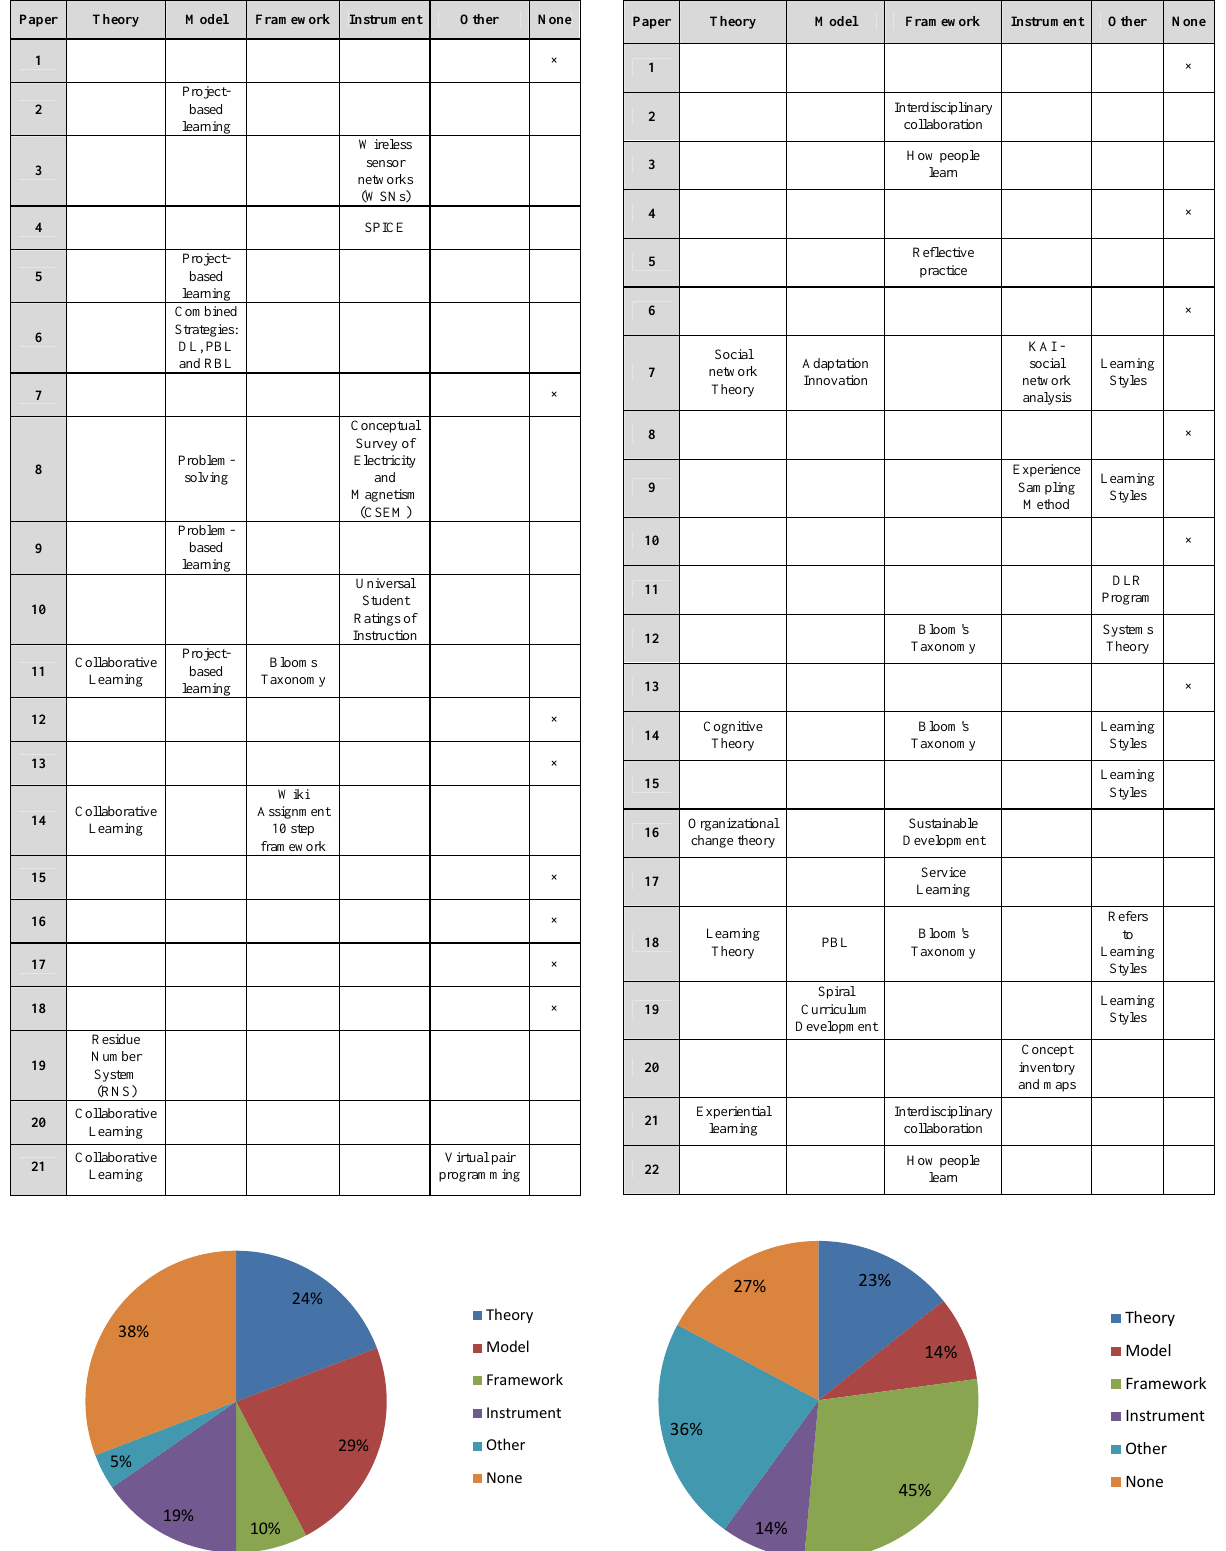
Figure 1. TMFI, IEEE Transactions Vol. 54, N. 1